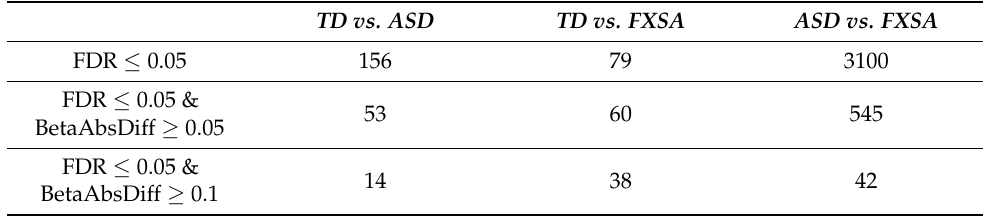
Table 2. Number of Differentially Methylated Sites (DMS) identified by the adjusted model. TD vs.